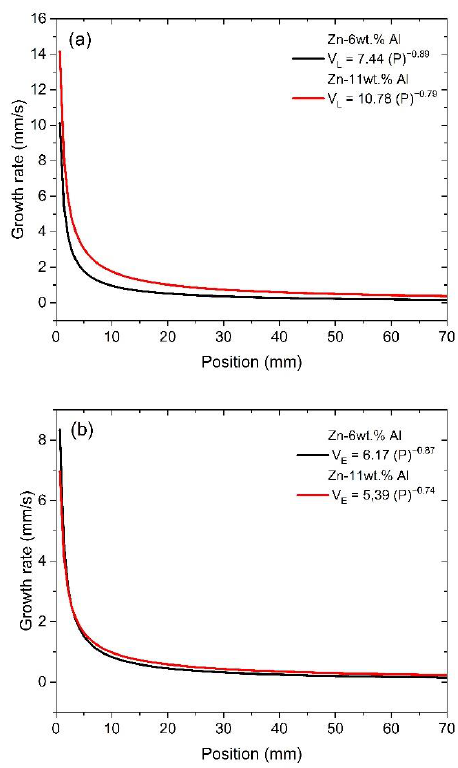
Figure 7. Growth rates as function of P for the Zn–6wt.% Al and Zn–11wt.% Al alloys castings: ( a ) liquidus isotherm (V L ), and ( b ) eutectic isotherm (V E ).